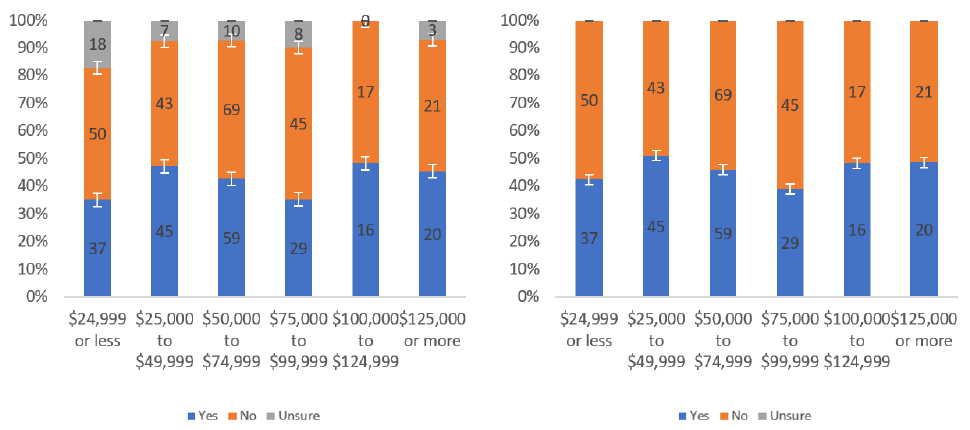
Figure 42. Responses regarding label annoyingness by income level including ( left ) and excluding ( right ) unsure responses.